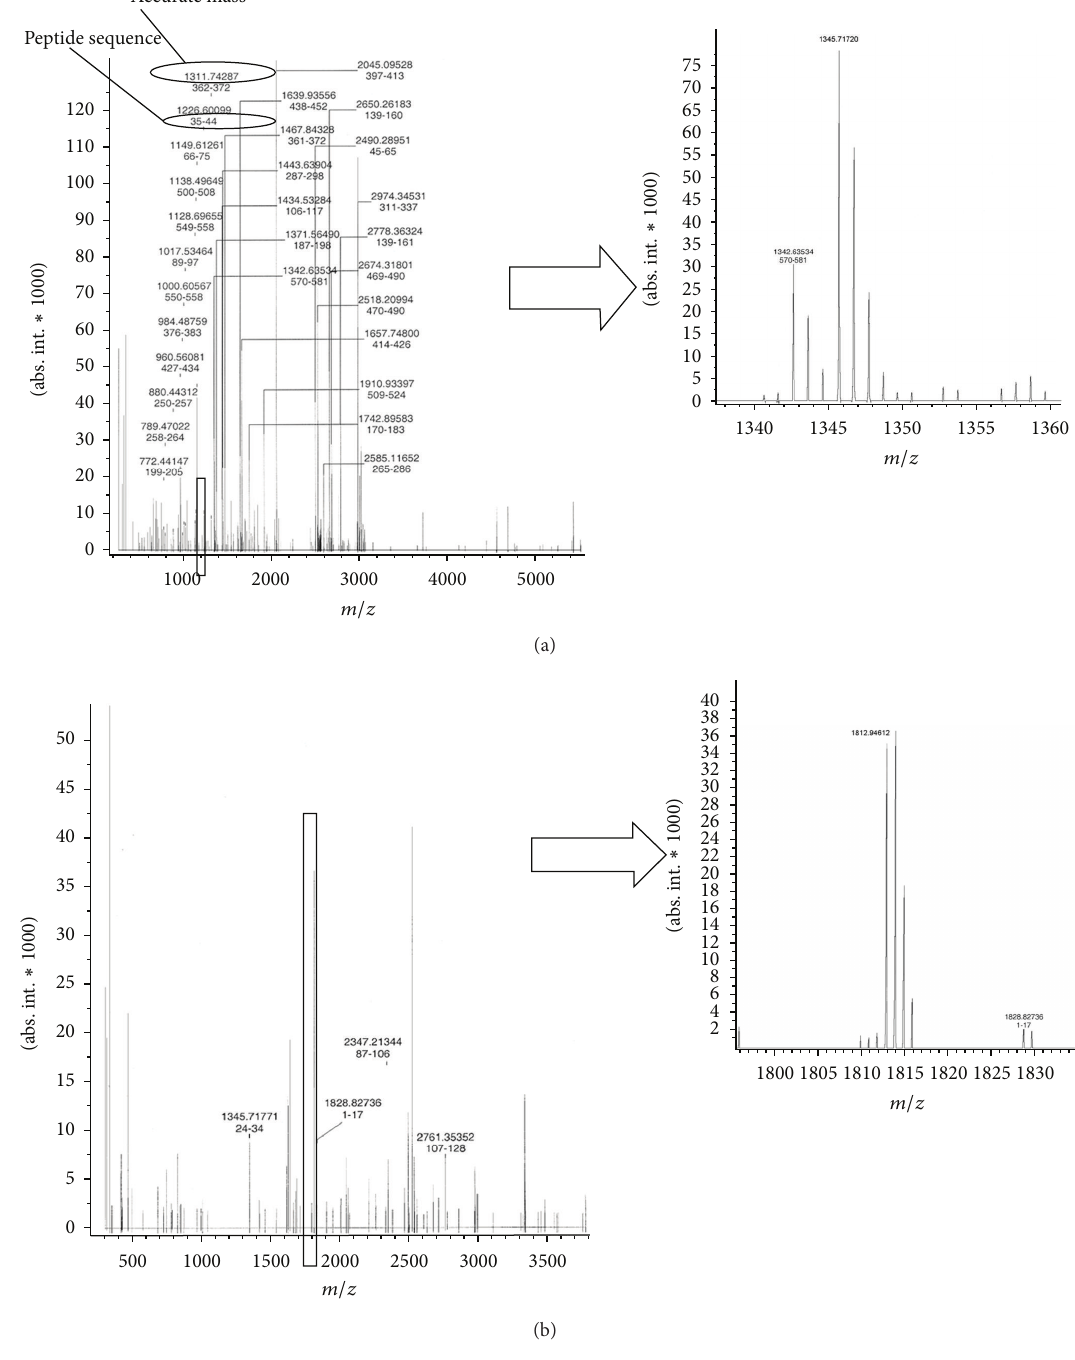
Figure 4: (a) FTMS ESI spectrum of the enzymatic digestion products of untreated HSA; (b) FTMS ESI spectrum of the enzymatic digestion products of in vitro glycated